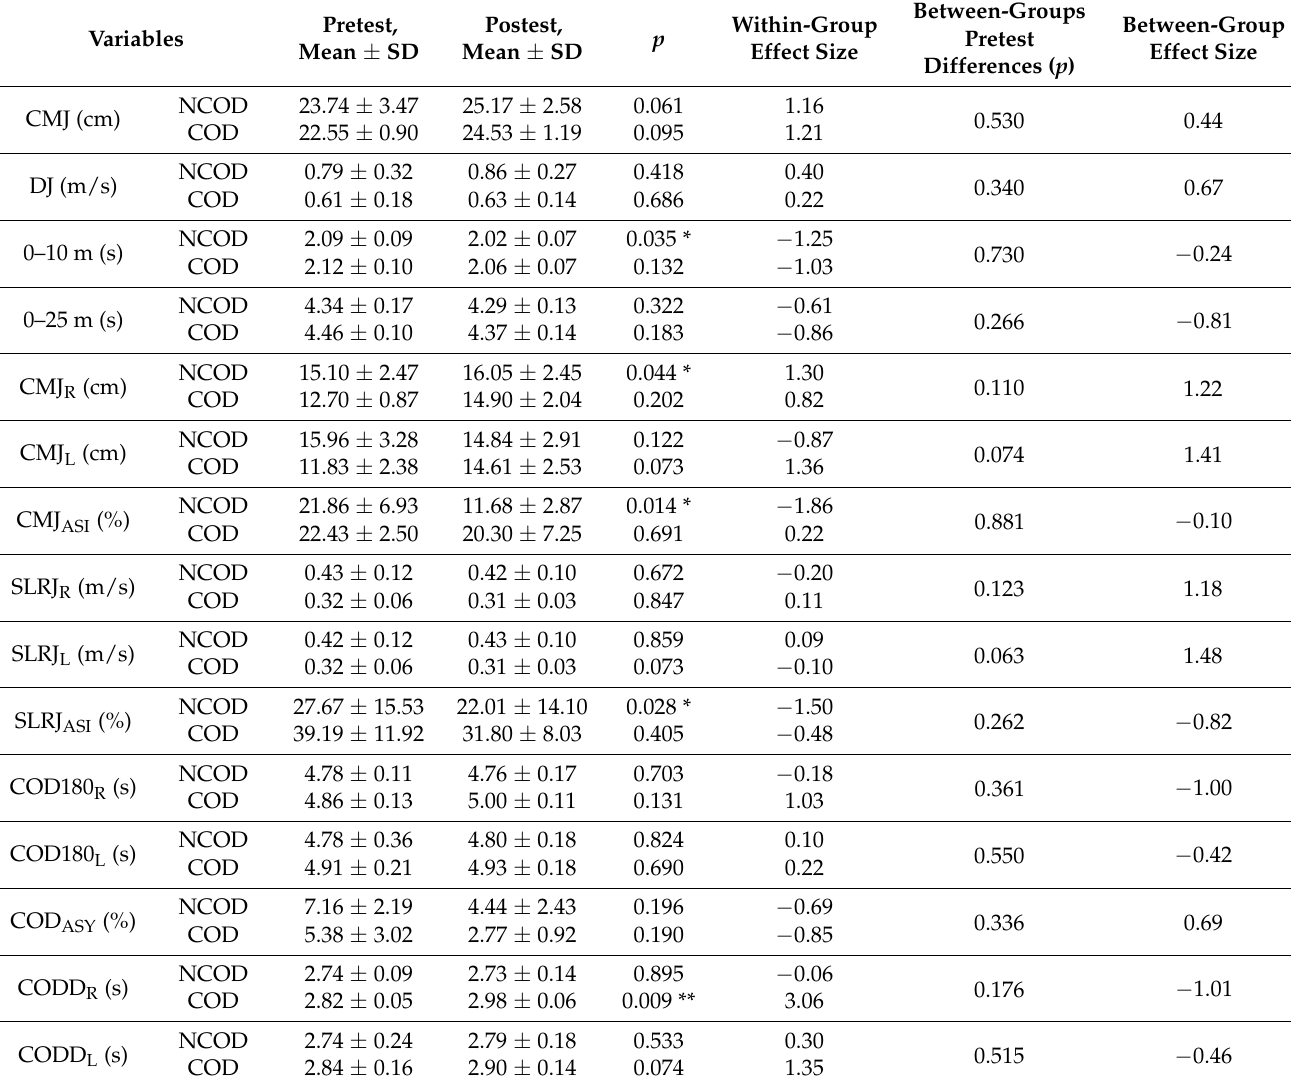
Table 3. Inferences of the training programs intervention on player’s performance